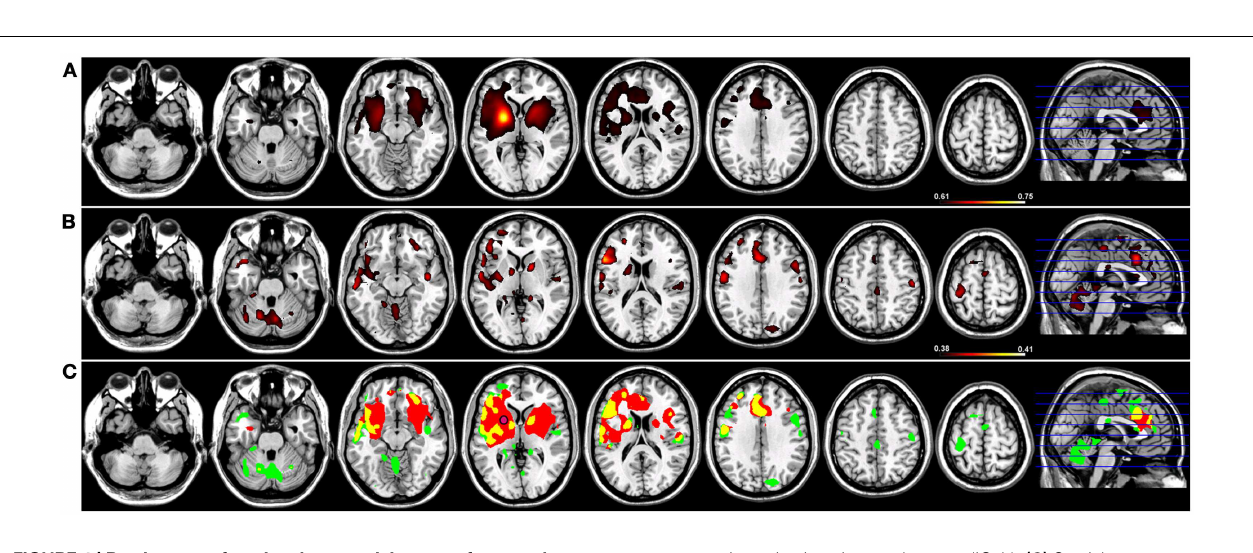
FIGURE 4 | Resting-state functional connectivity maps for a seed placed in the left putamen (pink circle) in 15 healthy control subjects reconstructing the left basal ganglia network (BGN) . (A) BGN reconstruction using magnitude coherence (Coh). (B) BGN